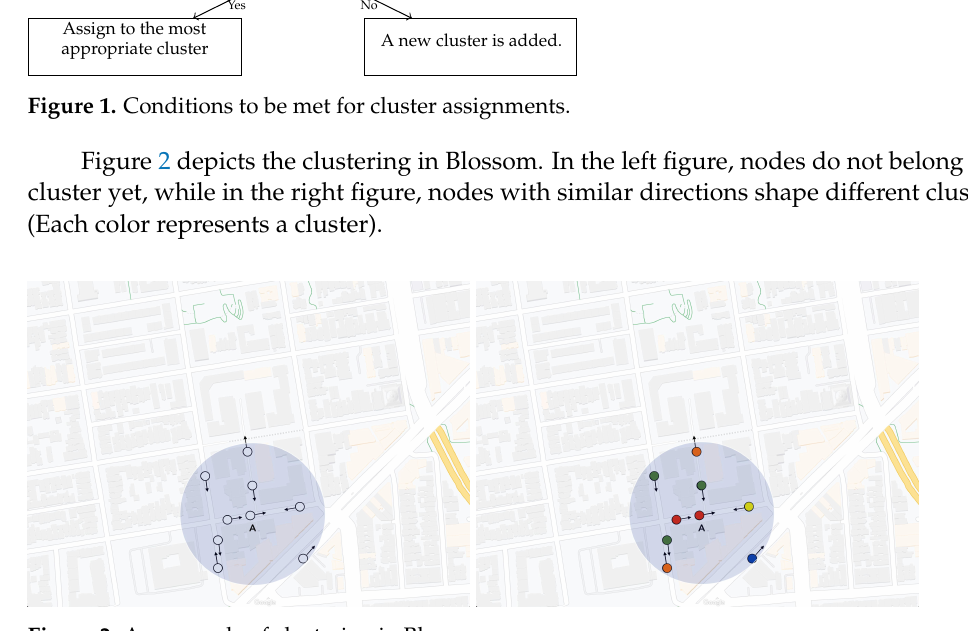
Figure 2. An example of clustering in